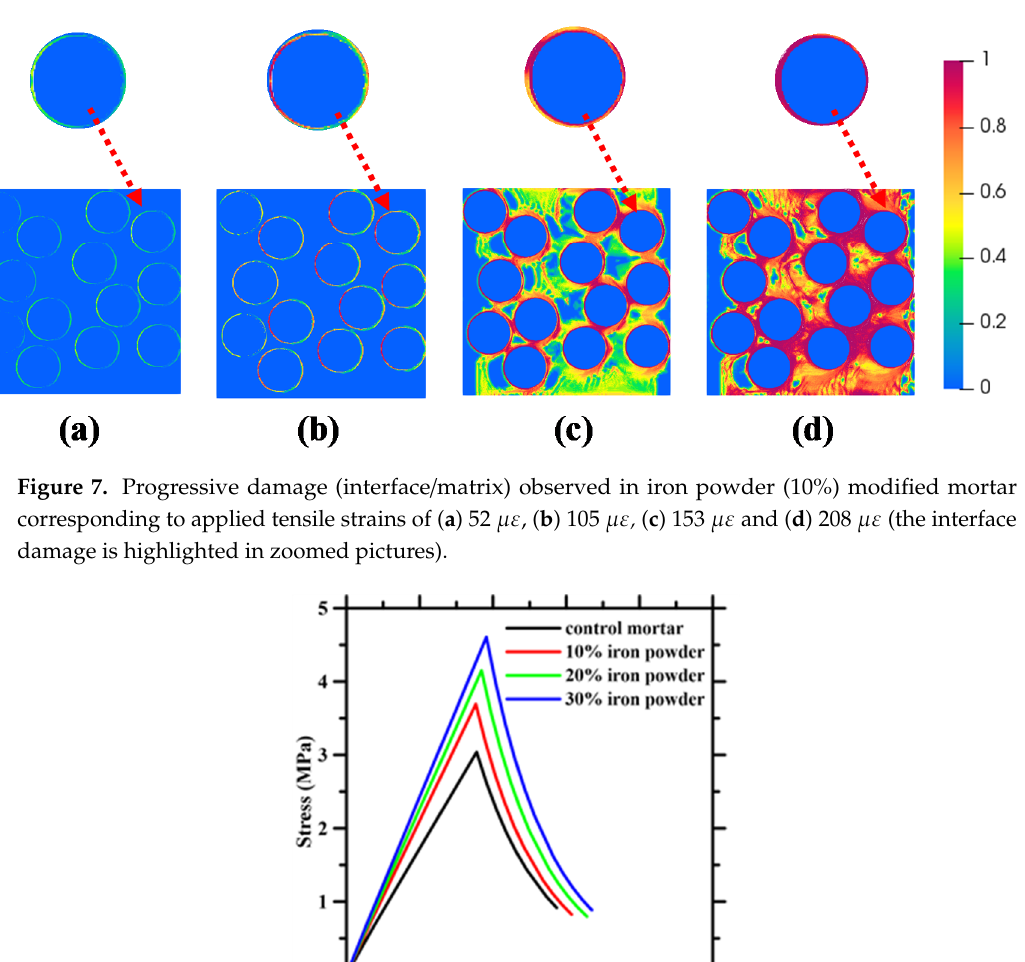
Figure 8. Simulated tensile constitutive response of mortars with varying iron powder dosage.